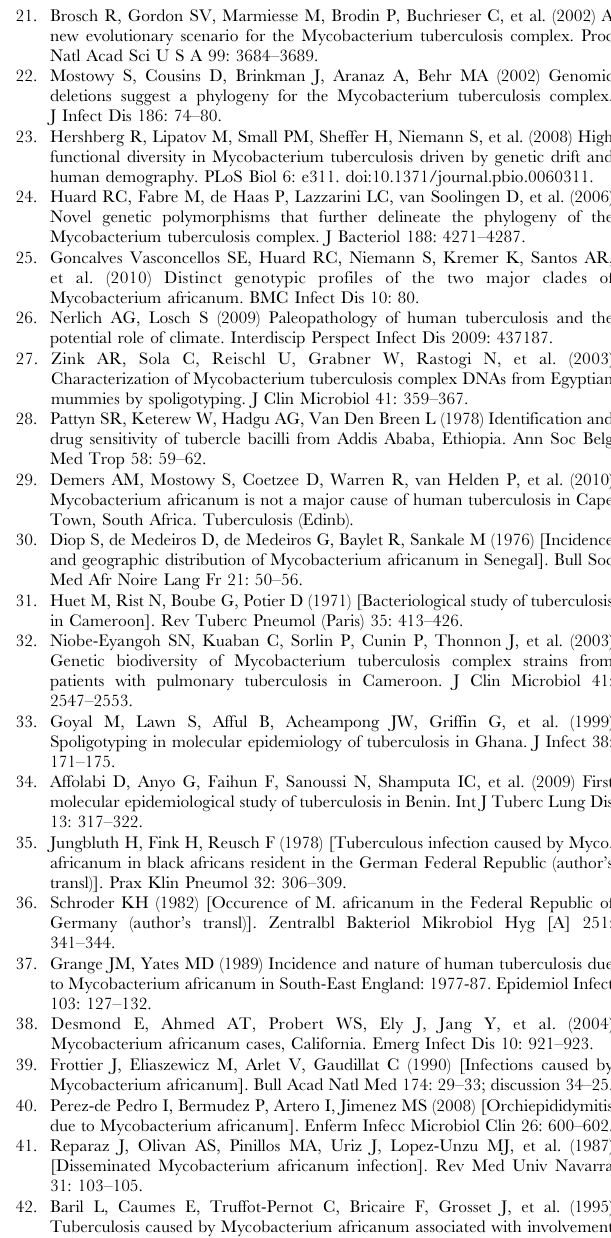
Table S1 Single nucleotide polymorphisms (SNPs) that define the various M. africanum lineages, based on [23] and